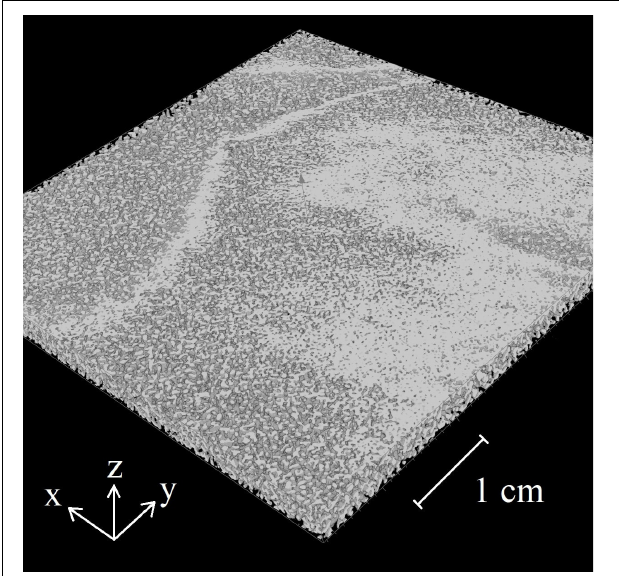
FIGURE 5 | Daily air temperature measurements of the years 2000–2015 (red dots) derived from AWS 9 and averaged to obtain an average annual cycle (red thick line); the difference between daily minimum and maximum temperature was calculated accordingly (blue); gray bars indicate a narrow, 4-month and a broader, 6-month summer period for summer deposition evaluation below (see text), color code according to the legend.